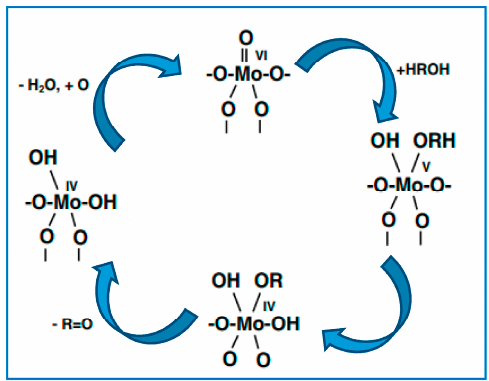
Figure 18. The oxidative dehydrogenation of methanol on molybdenite catalysts as proposed by Bowker et al. [22].